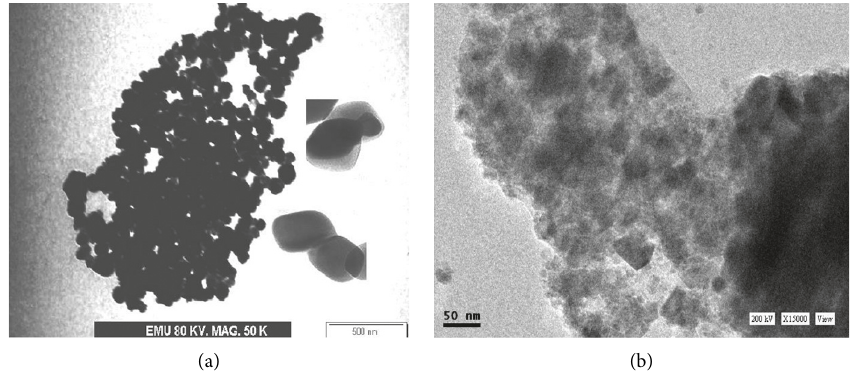
Figure 2: TEM image of the (a) CuO colloids and (b) 8 wt% CuONPs-doped HEC sample.